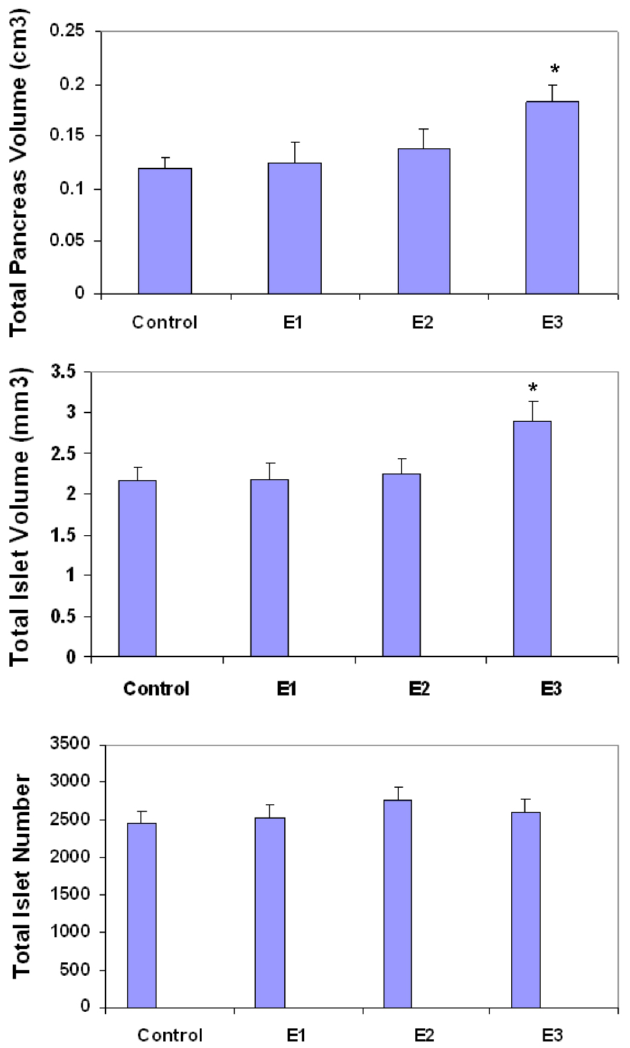
FIGURE 4 - Total pancreas volume, total islet volume and total islet number of control and experimental groups. Values expressed as means ± SD for 8 mice. * P < 0.05 compared to control group.